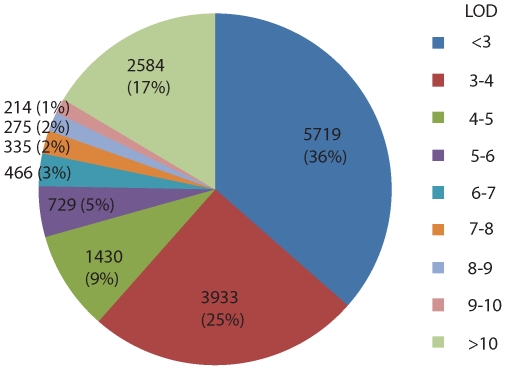
Numbers and proportions of eQTL with different LOD scores.A total of 15685 significant eQTL (p<0.001) was detected with LOD scores ranging from 2.4 to 55.7.